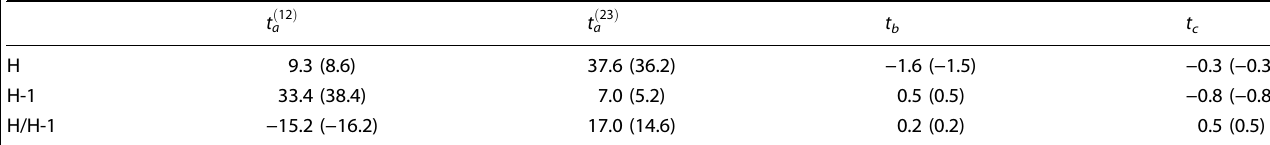
Table 1. DFT estimates of the transfer integrals t ð ij Þ a (in meV, with i , j = 1, 2, or 3) for molecular pairs extracted from the spiro-OMeTAD crystal illustrated in Fig. 1b for the couplings between the HOMOs (H), the HOMO-1s (H-1), and the HOMO and HOMO-1 (H/H-1) of the individual molecules. The calculations were performed at the Opt - ω B97X-D/6-31 G** and (in parentheses) B3LYP/6-31 G** levels of